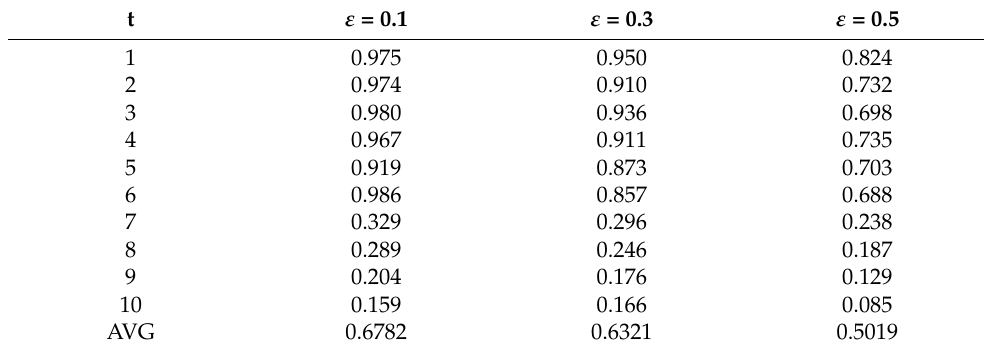
Figure 8. Two evaluation indexes of four algorithms on two datasets after manual processing. ( a ) QC modularity on Cora dataset; ( b ) NMI values on Cora dataset; ( c ) QC modularity on Wiki dataset; ( d ) NMI values on Wiki dataset. Table 2. Influence of Different ε Influence on NMI value of our